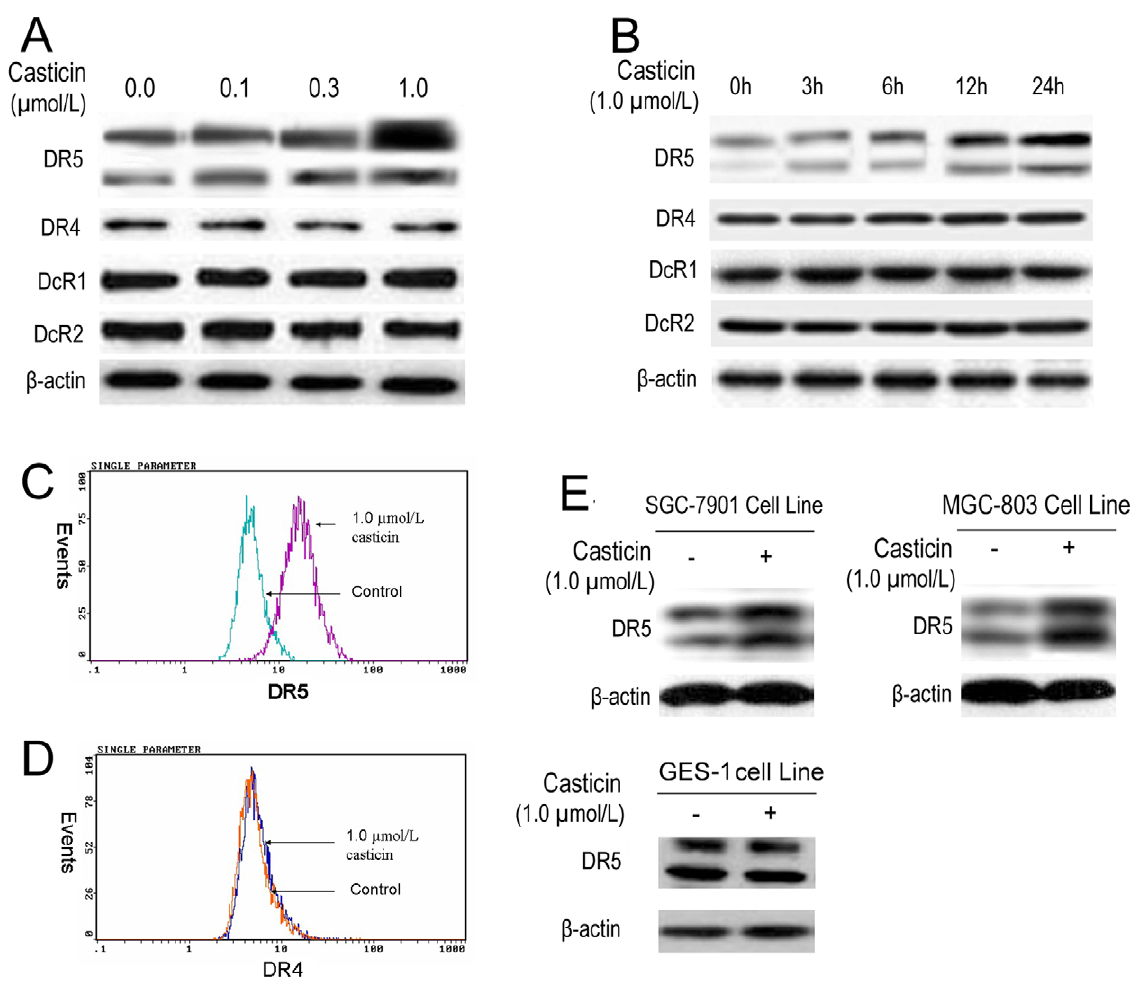
Figure 3. Casticin significantly increased the level of DR5 expression in gastric cancer cell lines. Effects of casticin on the level of TRAIL receptor expression determined using western blot (A and B) and the cell superficial DRs by flow cytometric analysis (C and D) in BGC-823 cells. Effects of casticin on the levels of DR5 protein levels in SGC-7901, MGC-803 and GES-1 cells using western blot analysis (E).